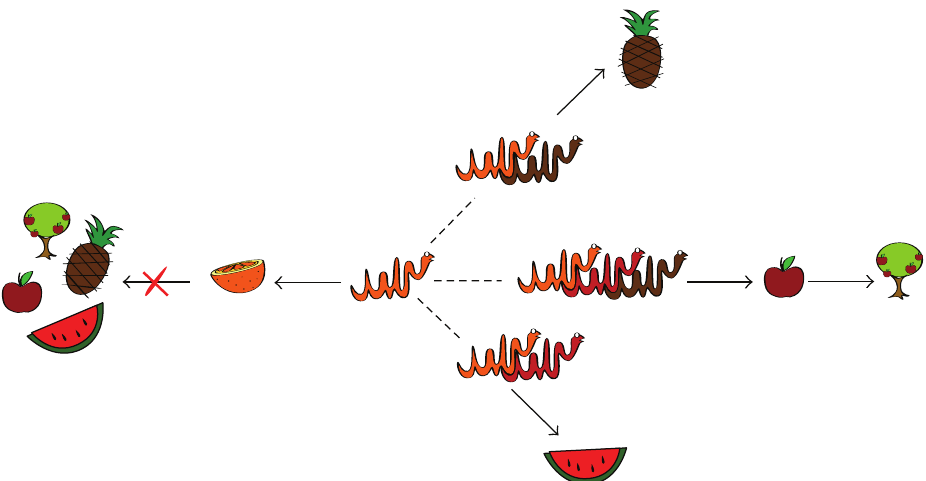
Figure 1: Cartoon showing that cooperation between different receptors may achieve objectives that are unobtainable for a single receptor. In a tribute to one of the names used for these receptors (serpentine receptors) they are depicted as serpents/snakes; each colored serpentine would correspond to a given GPCR. The fruits and the fruit tree are a pictorial metaphor of cell/biological functions that may be reached by activation of GPCR monomers, dimers, or trimers. Copyright is retained by N.